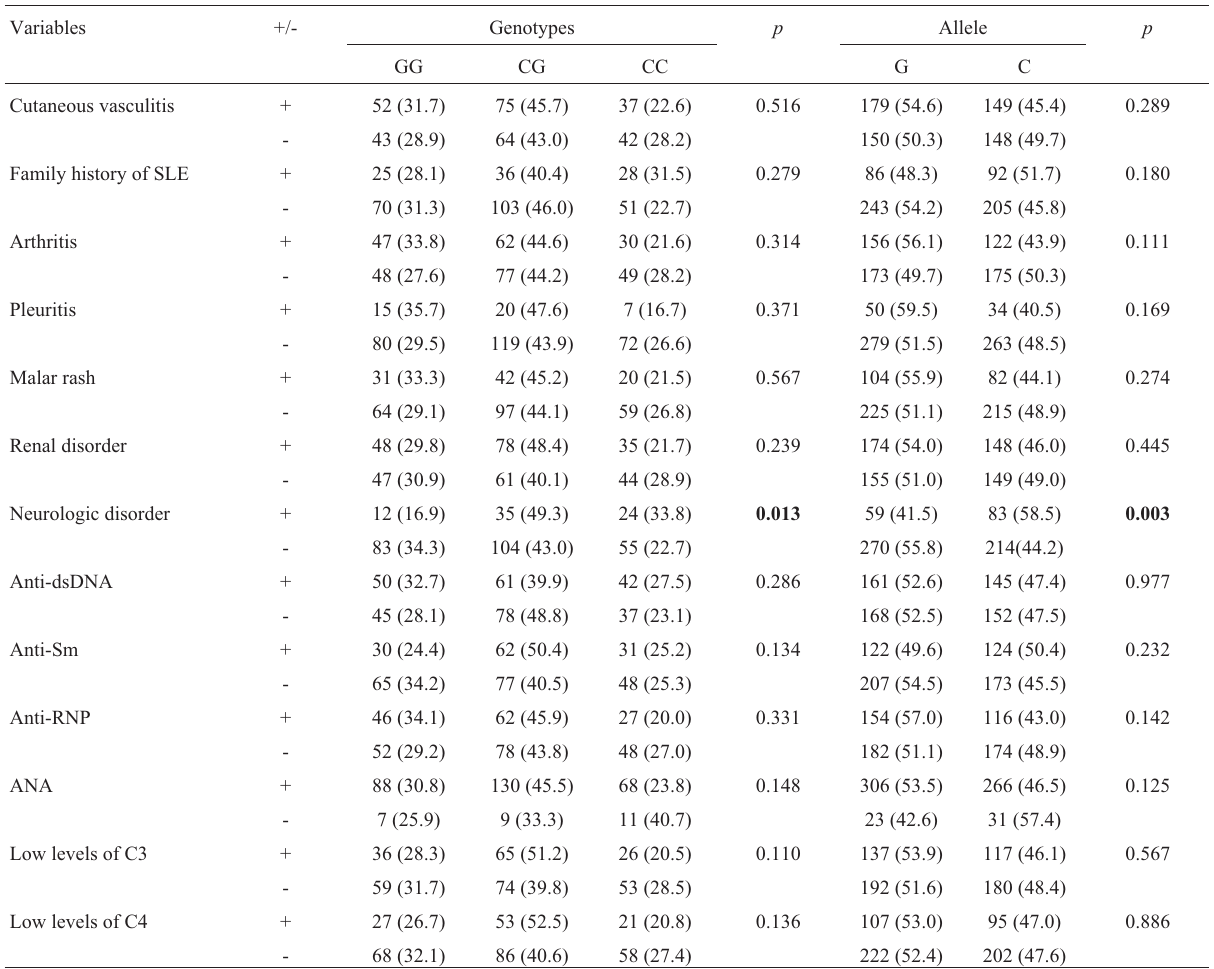
Table 4 - Association analysis of rs1051169 polymorphism with clinical features.